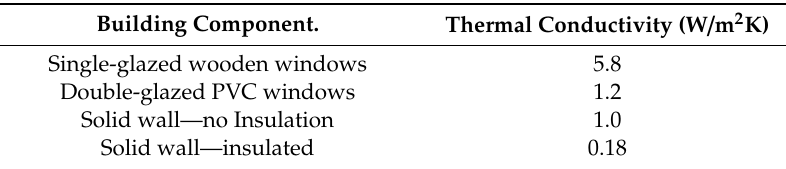
Table 3. Heat Transfer co-e ffi cient for building